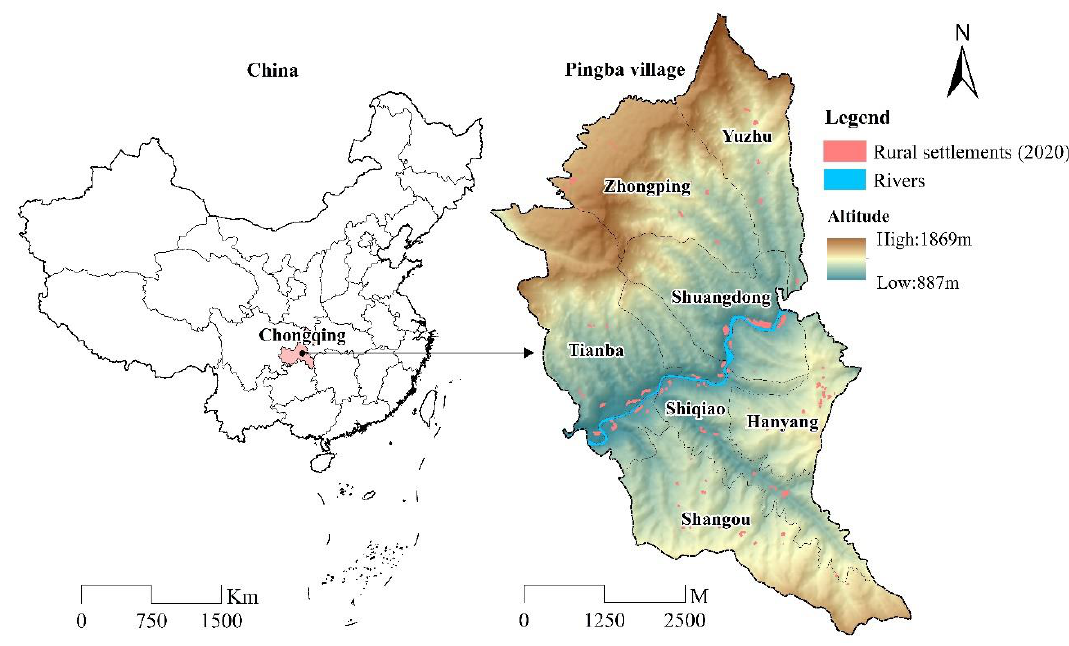
Figure 1. Location of the study